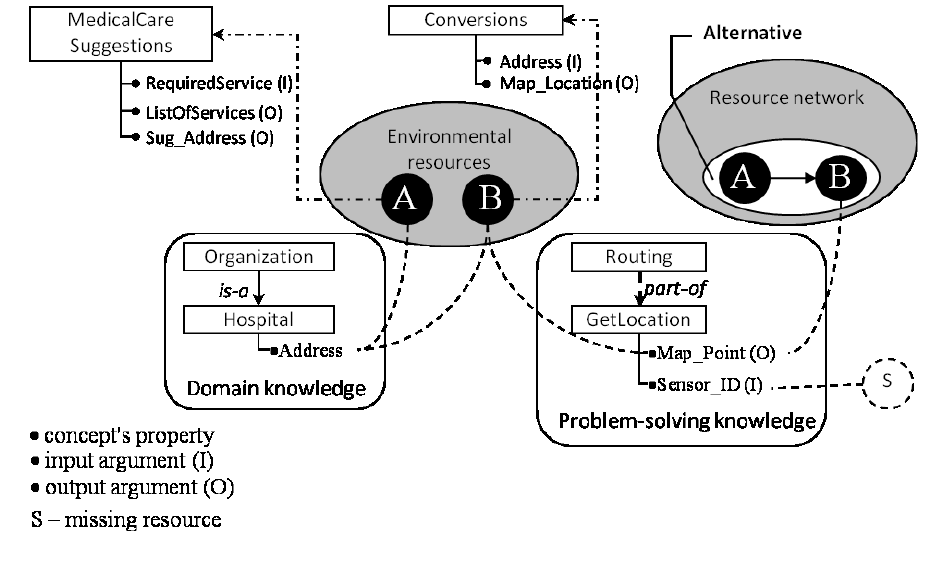
Figure 3. Discovery of alternative problem-solving